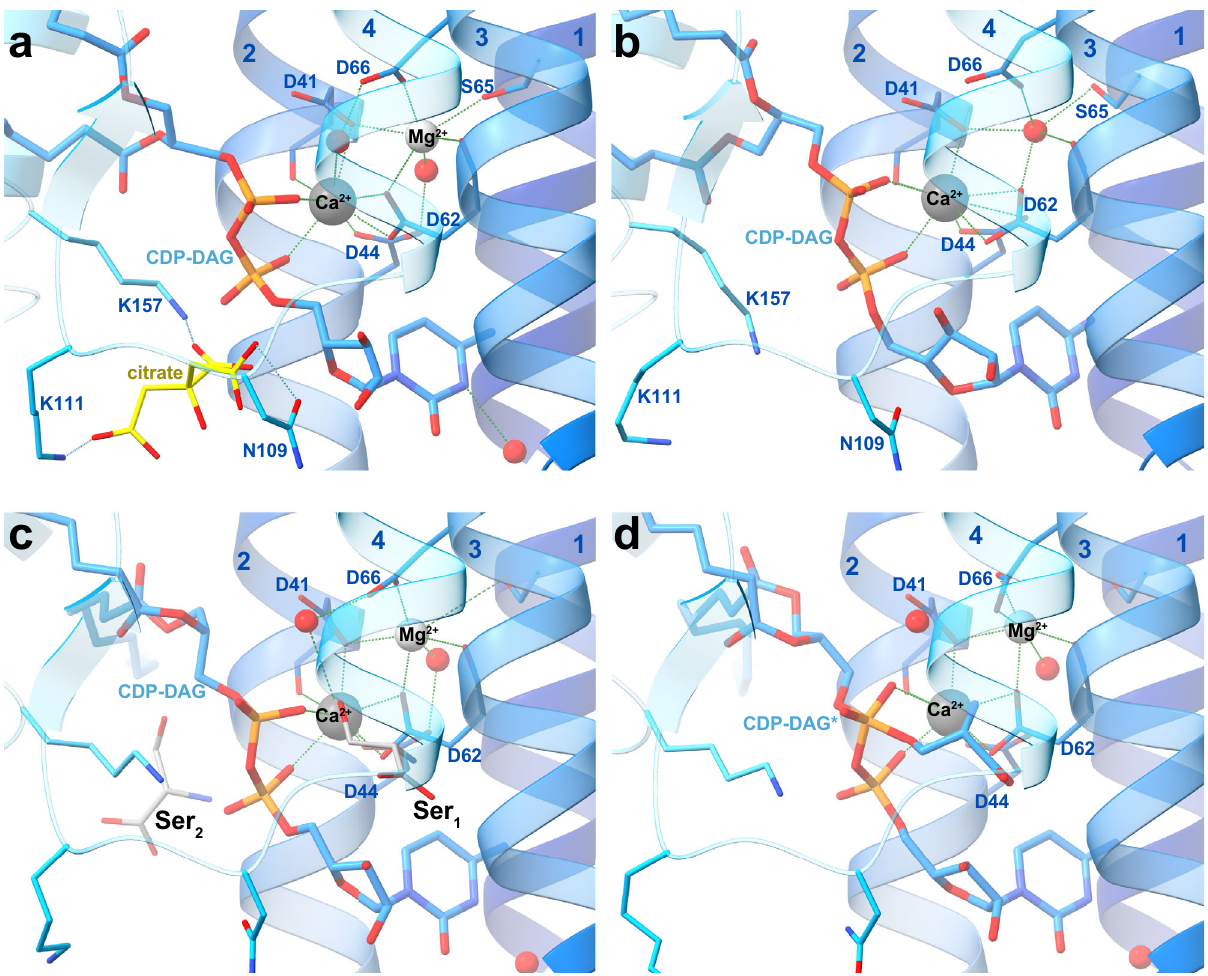
Fig. 4 Substrate coordination in the MjPSS binding pocket. a MjPSS in the closed conformation of the native protein with bound CDP-DAG, Ca 2 + , Mg 2 + , and a citrate molecule in the substrate-binding pocket. The citrate molecule is coordinated by Asn109, Lys111, and Lys157, and coordination of the metal ions and CDP-DAG is mediated by the highly conserved residues Asp41, Asp44, Asp62, and Asp66. b When MjPSS is crystallized with additional Ca 2 + , it adopts the same closed conformation as in the other closed native structure ( a ). In this structure, Ca 2 + is in the same position, but the density at the position of Mg 2 + and the coordination geometry could not prove the presence of Mg 2 + with certainty, so we modelled this density as a water molecule. c The metal coordination of MjPSS in the open conformation resembles the native structure. In this structure, two serine-binding sites are present. In the Ser 1 site formed by helix 2, helix 3, CDP-DAG, Ca 2 + and Mg 2 + ions, Ala59 and Ser63, the serine is in the optimal position to react with the β -phosphate of CDP- DAG, whereas the position of the serine in the Ser 2 site is less optimal for the reaction. The Ser 2 site is located near the site where the citrate is non- speci fi cally bound to MjPSS ( a ). d In the second open structure, the serine in the Ser 1 site is covalently linked to the CDP-DAG in one protomer that probably represents the transition state, whereas in the second protomer serine and CDP-DAG are not